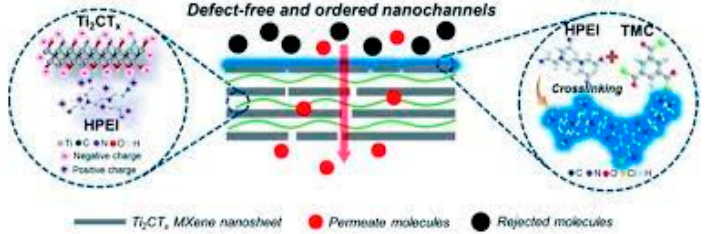
Figure 20. Schematic representation the ordered and fault-free MXene nanochannels produced by HPEI molecules following interfacial polymerization with TMC.